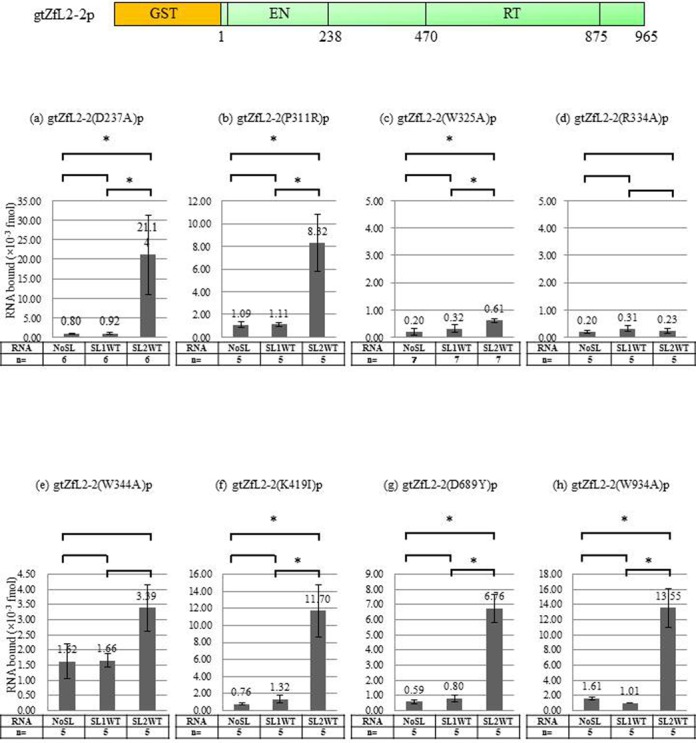
The region between the EN and RT domains of ZfL2-2 protein is responsible for binding its cognate stem-loop RNA. Binding assay with various mutated ZfL2-2p and SL2WT (or NoSL) was performed as in Figure 3. The schematic shows the domain structure of gtZfL2-2p with amino acid residue positions numbered. (a) gtZfL2-2(D237A)p; (b) gtZfL2-2(P311R)p; (c) gtZfL2-2(W325A)p; (d) gtZfL2-2(R334A)p; (e) gtZfL2-2(W344A)p; (f) gtZfL2-2(K419I)p; (g) gtZfL2-2(D689Y)p; (h) gtZfL2-2(W934A)p. At least five independent experiments were done for each protein. The asterisk indicates P < 0.05 by Bonferroni.